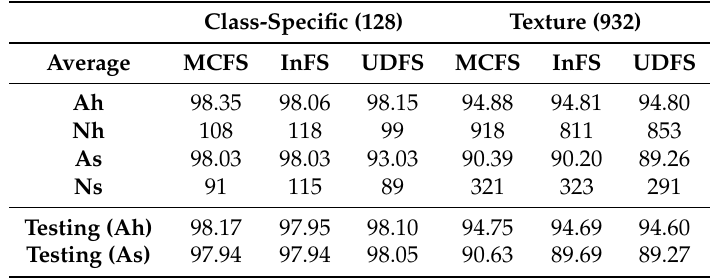
Table 5. Unsupervised features selection methods: Experimental protocol 1.